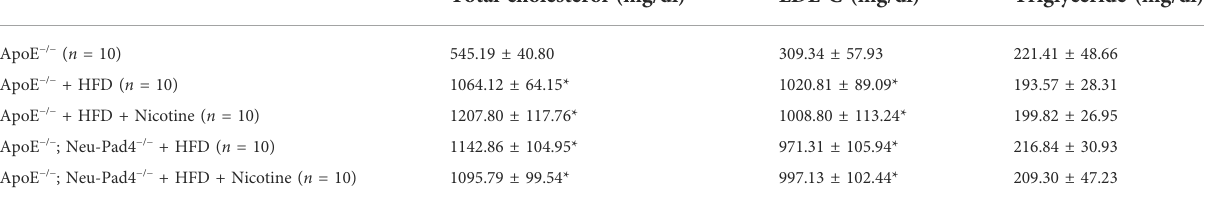
TABLE 1 The serum lipid pro fi le.